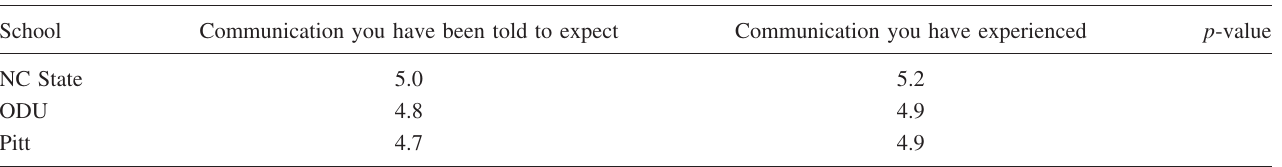
TABLE V. Communication violation attitude measure